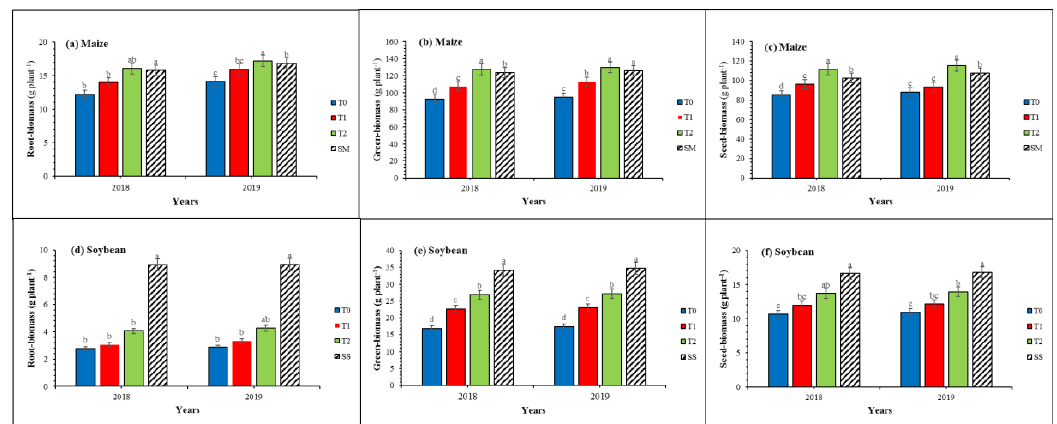
Figure 3. Root, green biomass and grain biomass of maize ( a – c ) and soybeans ( d – f ) as a ff ected by di ff erent potassium treatments in the maize–soybean intercropping system (MSI) from 2018 to 2019 growing season. The T 0 , T 1 and T 2 represent the no potassium treatment, 40:30 kg ha − 1 and 80:60 kg ha − 1 , respectively, in MSI. The SS and SM refer to sole cropping system of soybeans and maize, respectively. Means are averaged over three replicates ± standard error. Means do not share the same letters in the column di ff er significantly at p ≤ 0.05.